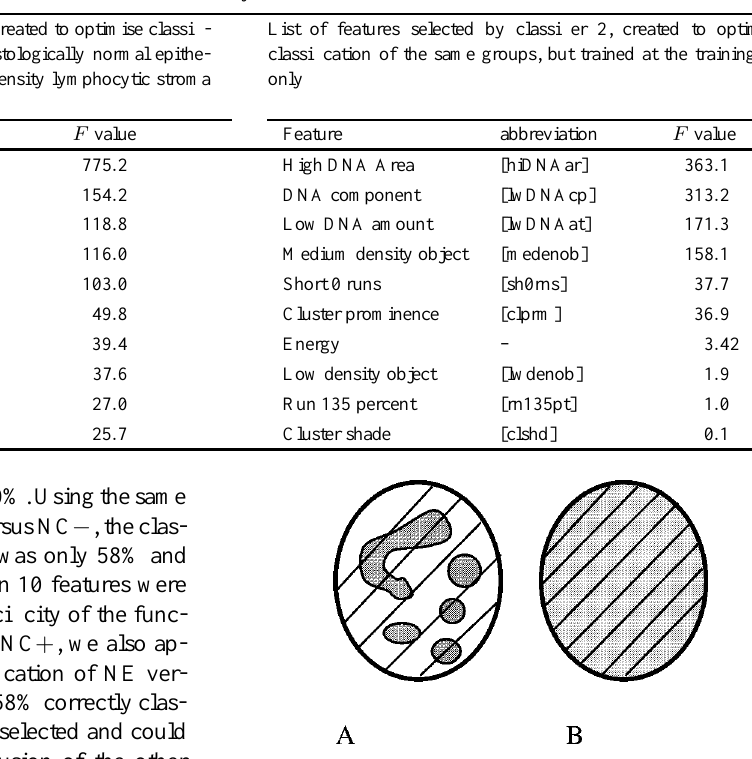
List of features selected by classifiers 1 and 2